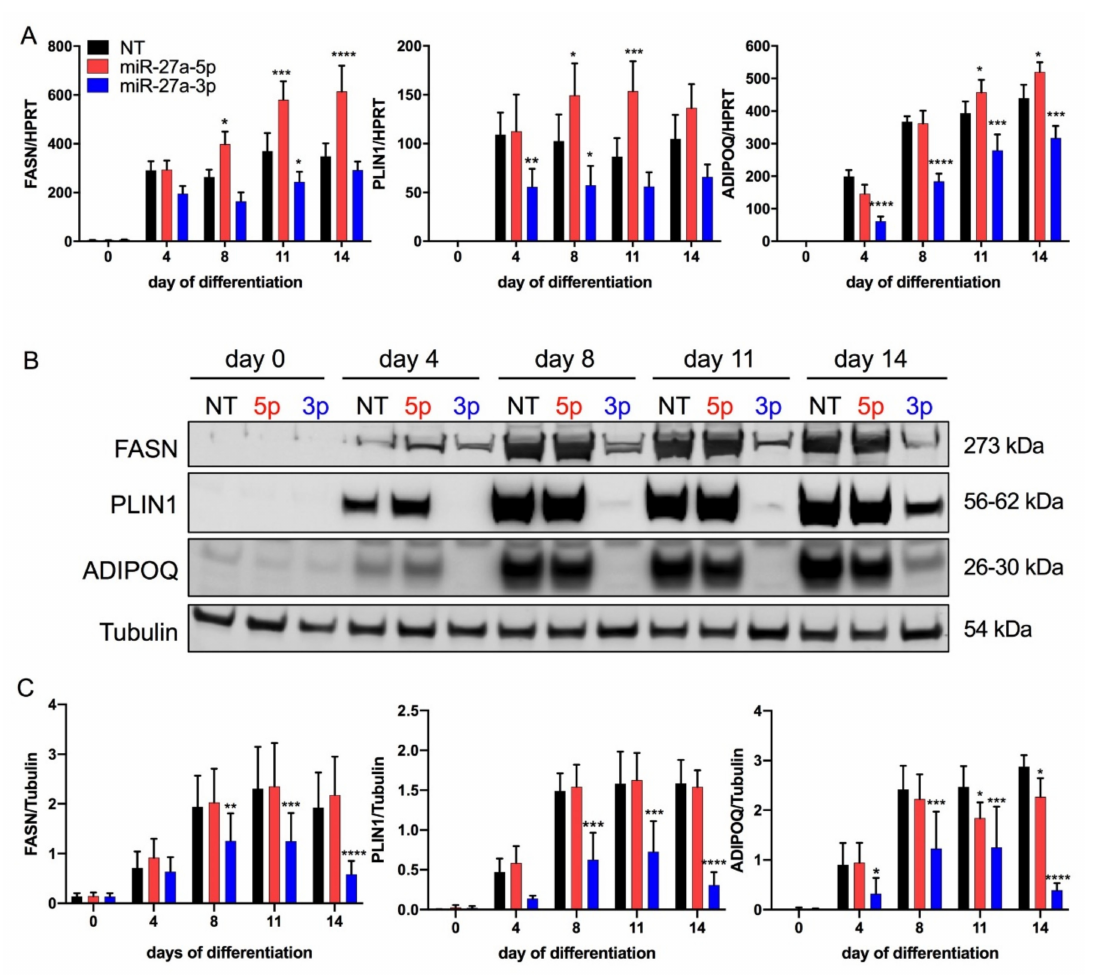
Figure 3. miR-27a-3p-mimic transfection markedly decreases adipogenic-marker expression. To assess the effect of miR- 27a-5p and -3p on human adipogenesis, SGBS preadipocytes were transfected 48 h prior to adipogenic induction with miRNA mimics or non-target control (NT, 20 nM). RNA and protein samples were collected on days (d) 0, 4, 8, 11, and 14 of adipogenesis. ( A ) mRNA expression of adipogenic markers as quantified by qPCR normalized to HPRT. ( B ) One representative Western blot out of three independent experiments with fatty-acid synthase (FASN), perilipin (PLIN1) and adiponectin (ADIPOQ), with tubulin as loading control. ( C ) Densitometric analysis of three Western blots. Statistics: results are displayed as means and SEMs of 5 ( A ) and 3 ( C ) independent experiments. Two-way ANOVA with Dunnett’s correction with respect to NT for the same time point; * p < 0.05; ** p < 0.01; *** p < 0.001; **** p < 0.0001. HPRT: